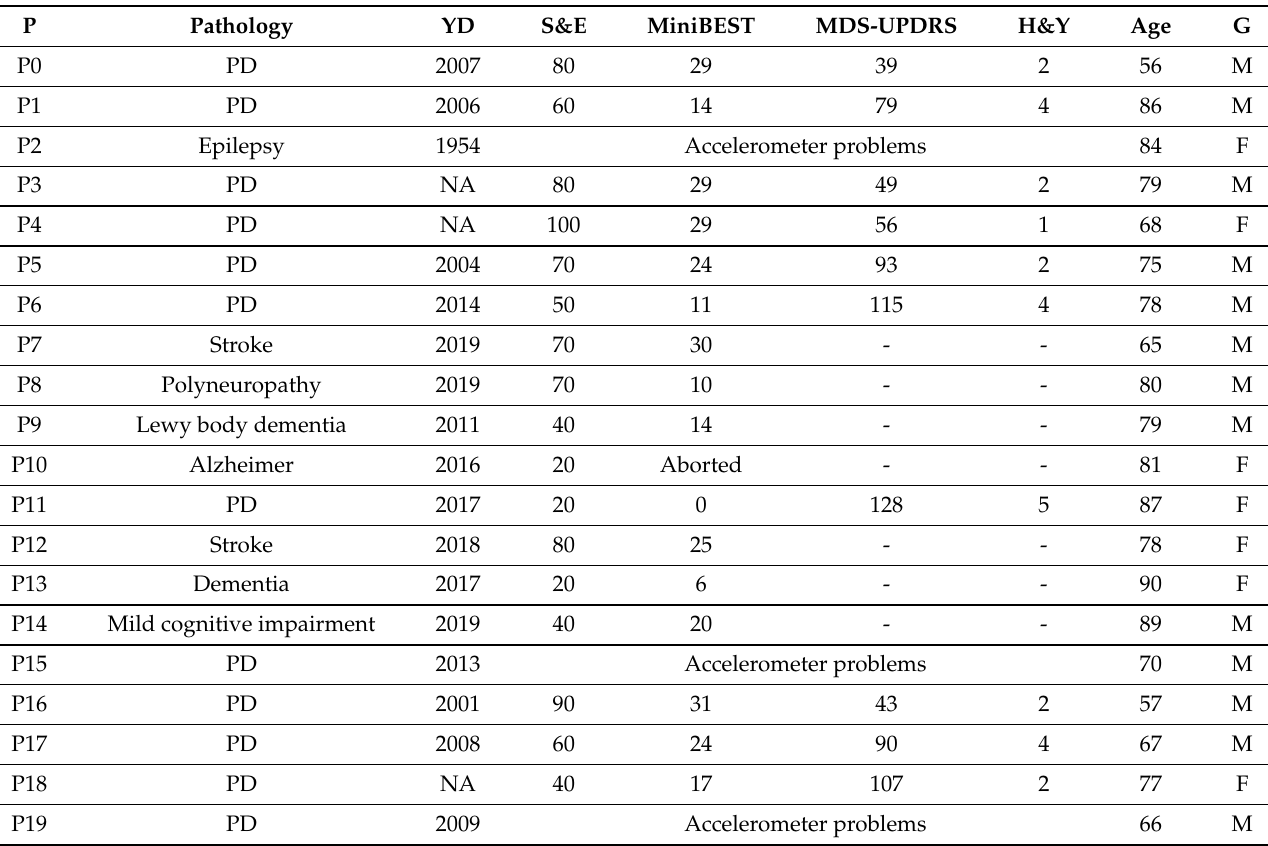
Table 3. Participants’ demographics and clinical information. G = gender; P = participant; YD = year of diagnosis; NA = not